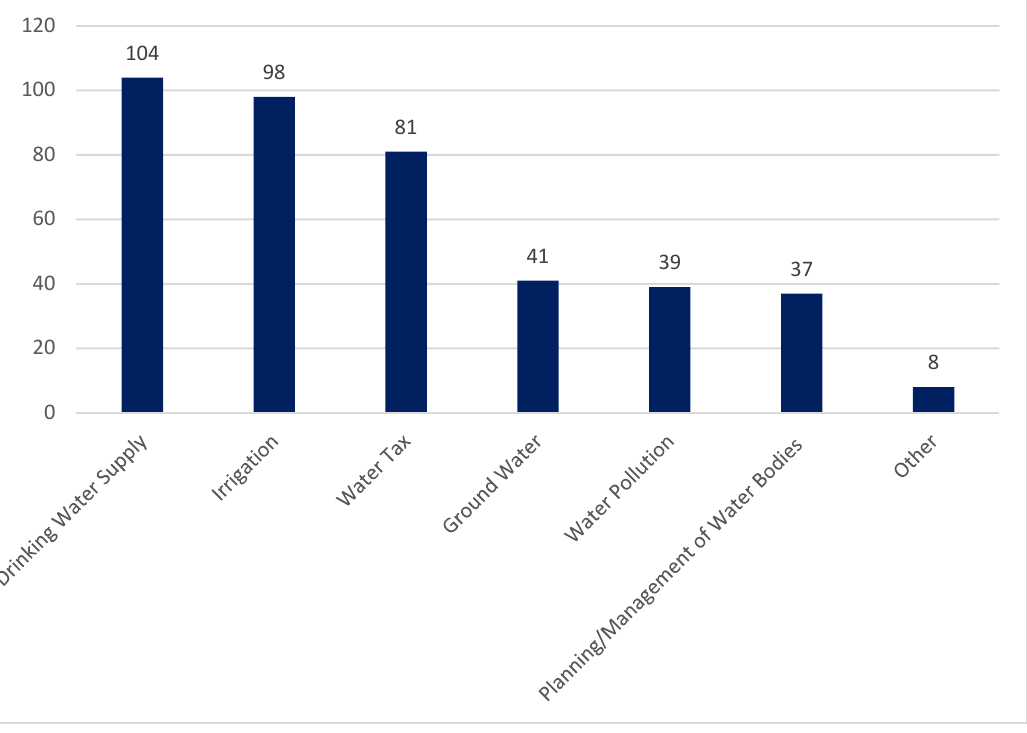
Figure 2. Major categories for water laws.